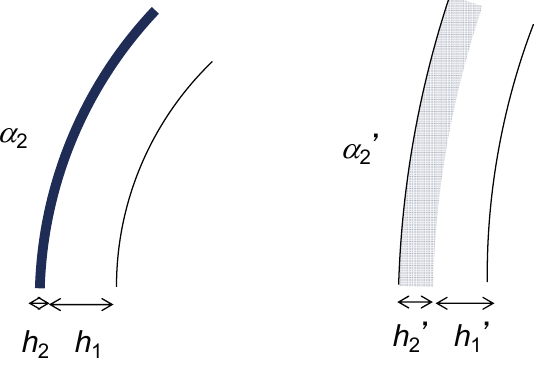
Figure 4. Illustration of the relationship between h 2 and α 2 when the UV light irradiation is conducted to the different face in the same